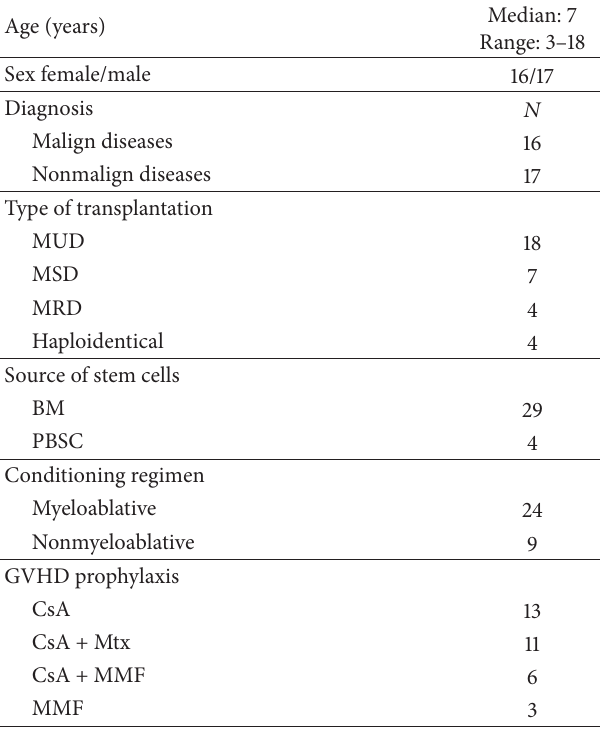
Table 1: Patients and HSCT characteristics.